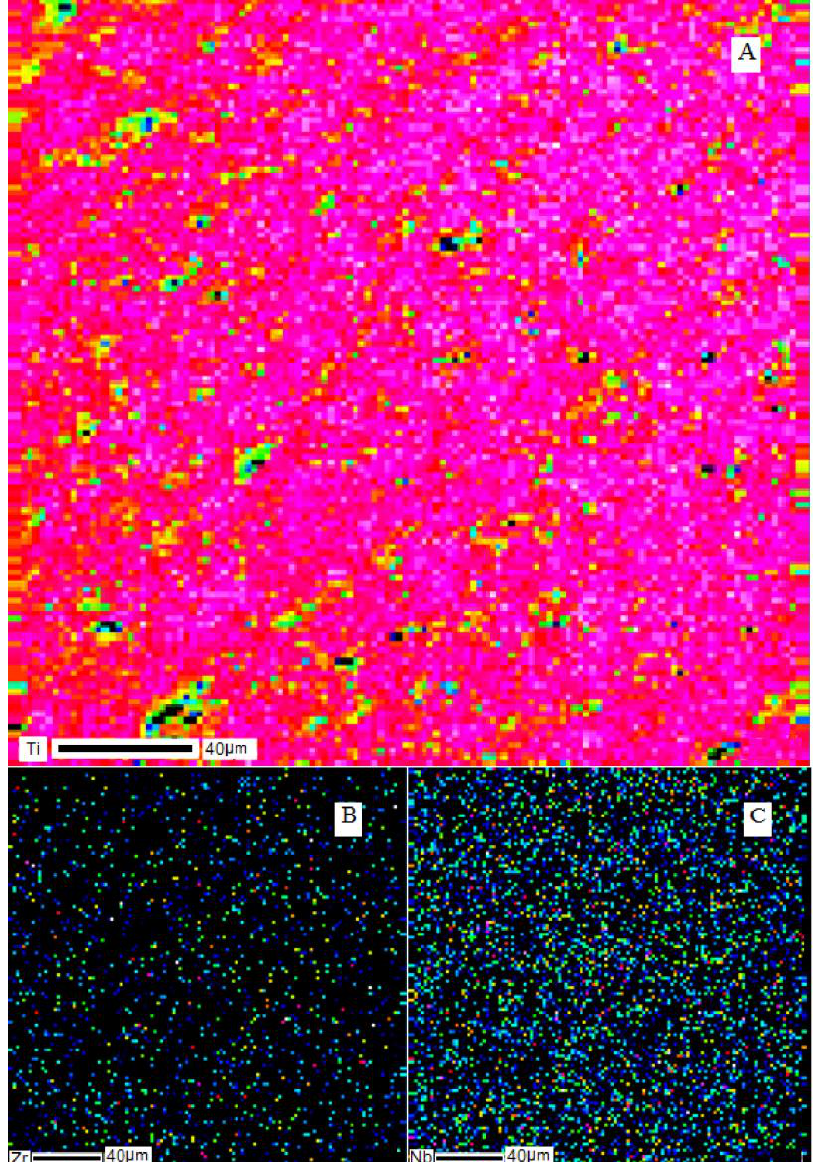
Figure 9. The element-wise distribution of metals in the structure of the Ti–28Nb–5Zr bar: ( A ) titanium; ( B ) zirconium; ( C ) niobium.